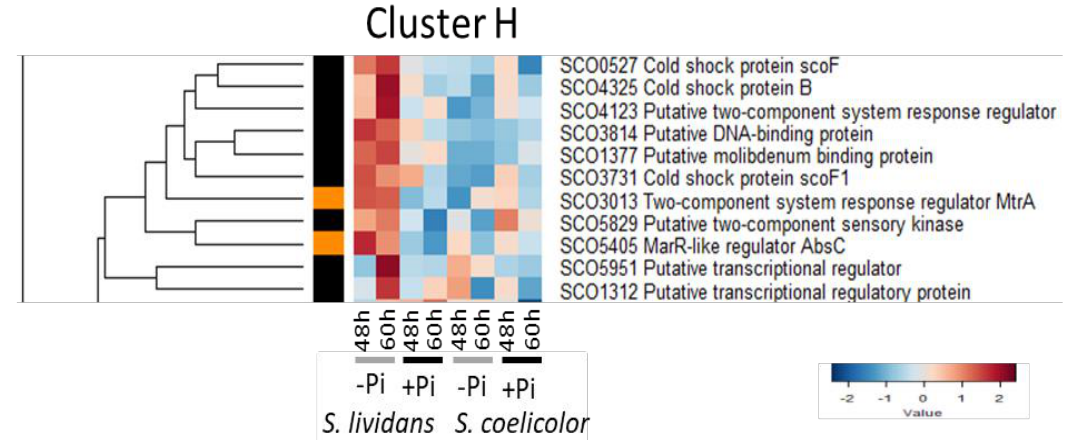
Figure 9. Cluster H, heatmap representation of transcriptional regulators and sensory histidine kinases more abundant in Pi limitation than in Pi proficiency in SL but not in SC.